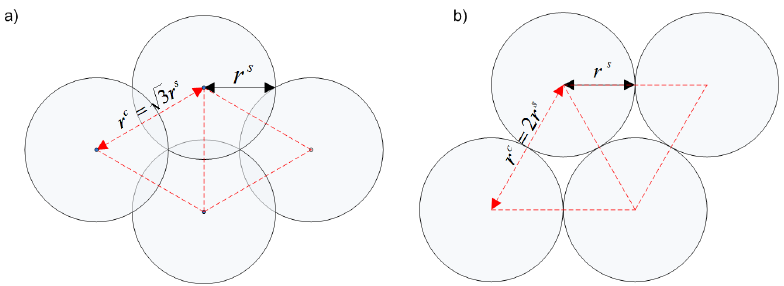
Figure 1. Regular grid topologies maintaining full coverage and connectivity ( r t ≥ r c ): ( a ) square with overlapping; ( b )